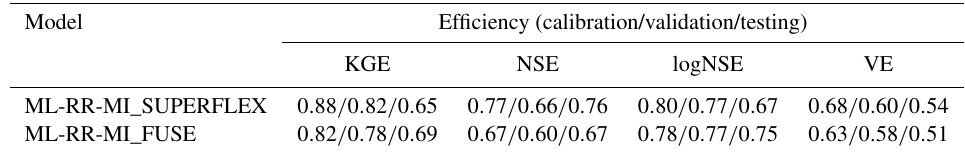
Table 8. Performance matrix of ML-RR-MI_SUPERFLEX and